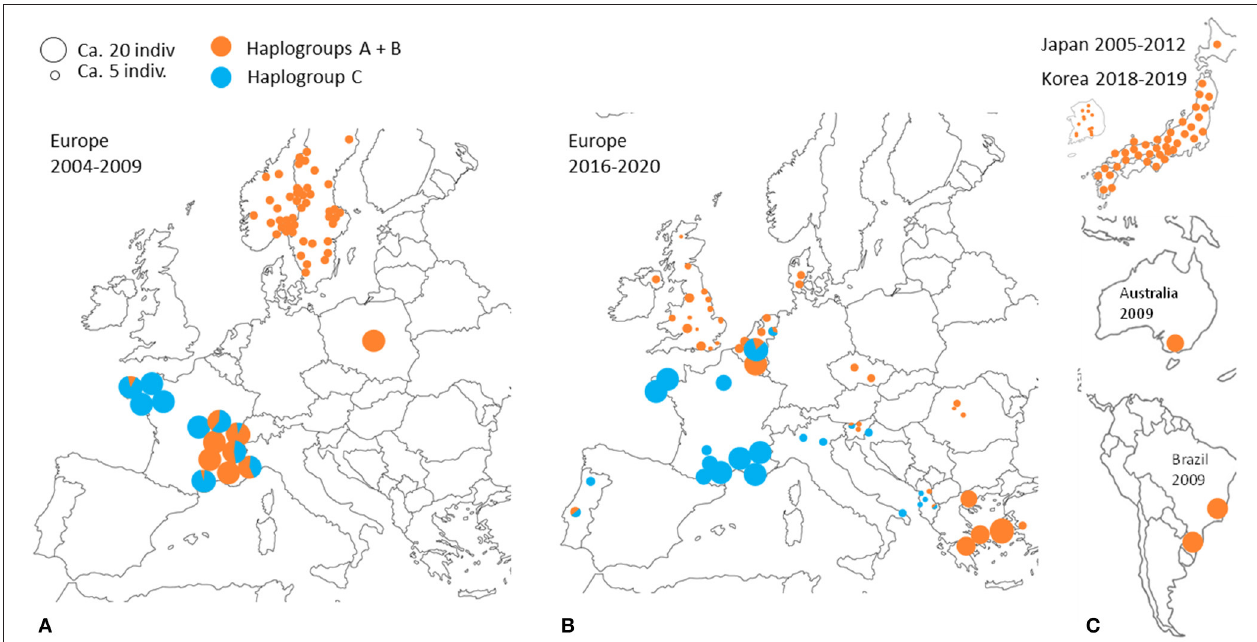
FIGURE 7 | Geographical distribution of typical CO1 haplotypes A + B and C at different periods according to data from (3, 4, 21–23). A disc represents a set of mite individuals collected from the same poultry house (or sometimes from several poultry houses within the same geographical entity) and the colors indicate the proportion of individuals carrying haplotypes A or B (orange) and individuals carrying haplotypes C (blue). The size of the disc is proportional to the number of individuals sequenced. (A) Previous decade in Europe (2004 and 2009). (B) Current decade in Europe (2017–2020). (C) Previous decade and the beginning of the current decade in other regions of the